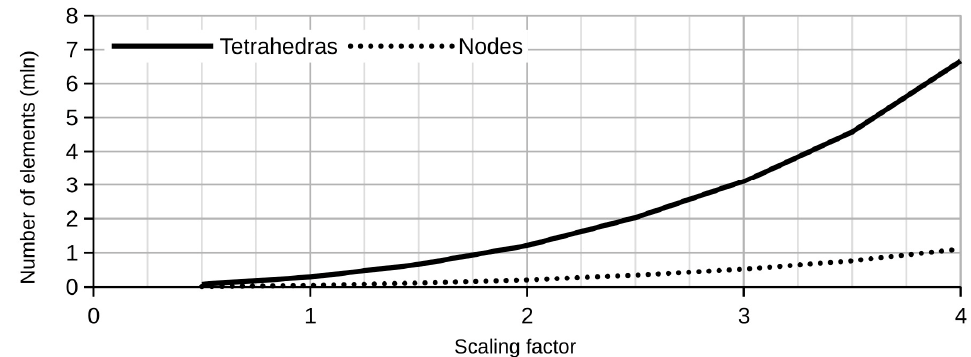
Figure 2. The dependence of the number of nodes and tetrahedrons in the finite element mesh on the scaling factor.